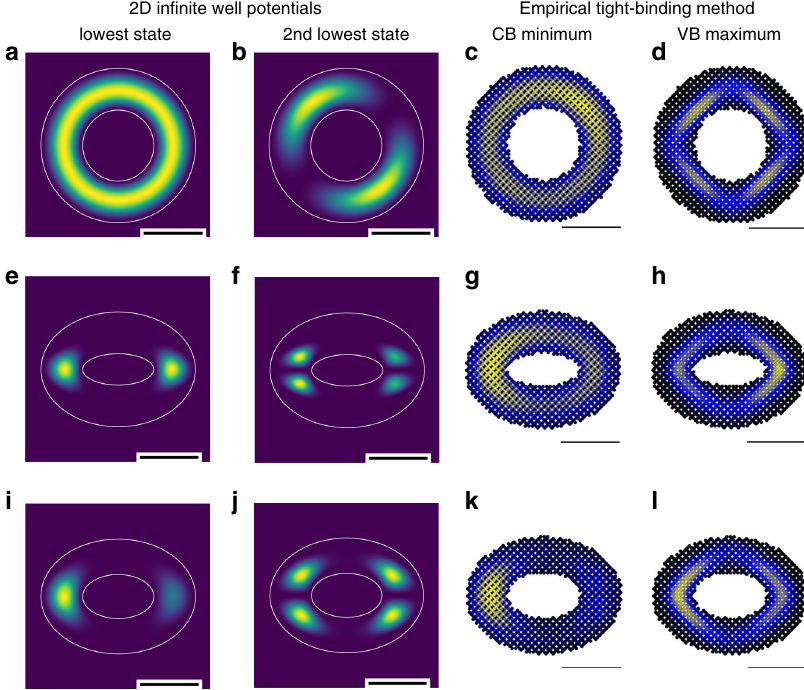
Fig. 4 Calculations of the electronic structures of CdSe quantum rings. a , b Calculated wavefunctions of the two lowest states of two-dimensional in fi nite well potentials with OD 1 = OD 2 = 13.3 nm, ID 1 = ID 2 = 6.1 nm, and t 1 = t 2 = 3.6 nm. c , d 2D slices of wavefunctions of a CdSe QR (OD 1 = OD 2 = 13.3 nm, ID 1 = ID 2 = 6.1 nm, t 1 = t 2 = 3.6 nm, and h = 5.0 nm) corresponding to the conduction band (CB) minimum c and the valence band (VB) maximum d calculated using an empirical tight-binding method. The slices are in the xy plane and cut through the center of the rings. e , f Calculated wavefunctions of the two lowest states of two-dimensional in fi nite ring well potentials with OD 1 = 13.3 nm, OD 2 = 9.9 nm, and ID 1 = 6.1 nm, ID 2 = 2.7 nm, and t 1 = t 2 = 3.6 nm. Breaking of the continuous rotational symmetry leads to the lifting of the p - and d - type orbitals as the two lowest states. An optical transition between these two orbitals has a uniaxial transition dipole. g , h 2D slices of wavefunctions of a CdSe QR (OD 1 = 13.3 nm, OD 2 = 9.9 nm, and ID 1 = 6.1 nm, ID 2 = 2.7 nm, t 1 = t 2 = 3.6 nm, and h = 5.0 nm) corresponding to the conduction band minimum g and the valence band maximum h calculated using an empirical tight-binding method. i , j Wavefunctions of the two lowest states of two-dimensional in fi nite ring well potentials with OD 1 = 13.3nm, OD 2 = 9.9nm, ID 1 = 6.1nm, ID 2 = 3.8nm, t 1 = 3.6nm, and t 2 = 3.0nm. k , l 2D slices of wavefunctions of a CdSe QR (OD 1 = 13.3nm, OD 2 = 9.9nm, and ID 1 = 6.1nm, ID 2